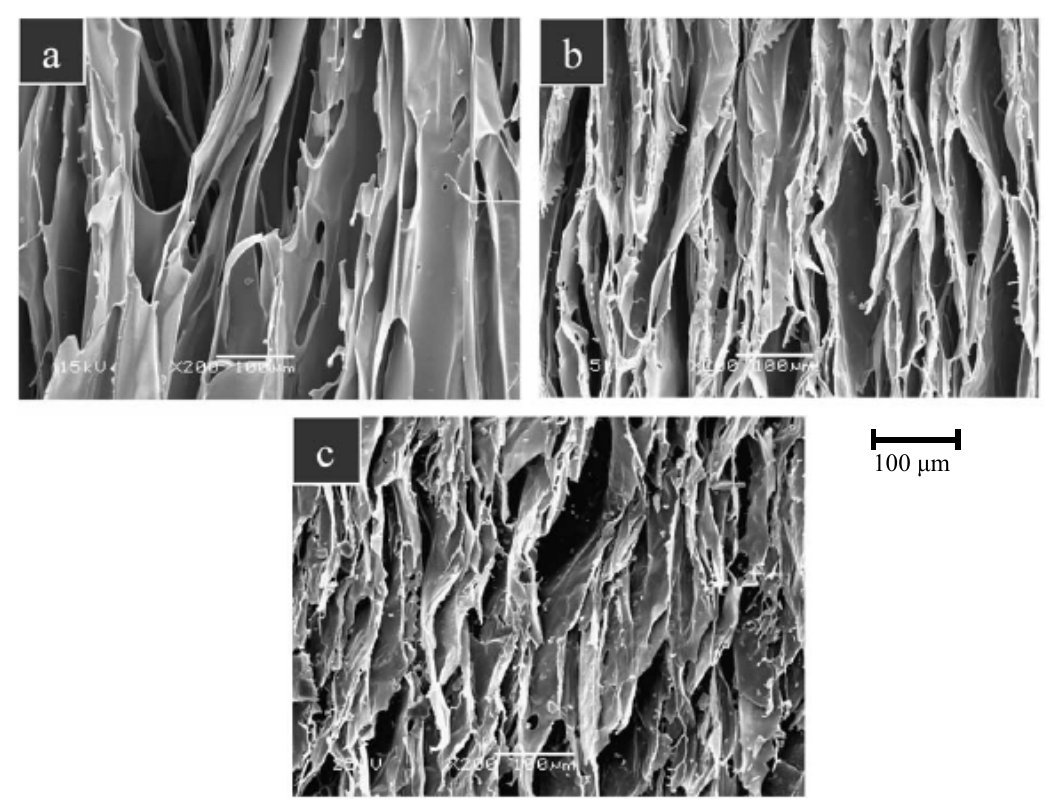
Figure 14. SEM images of a PDLLA/Bioglass ® scaffold fabricated by TIPS showing the typical homogeneous, tubular regions of (a) pure PDLLA foam, (b) PDLLA / 4.8 wt % Bioglass ® foam, (c) PDLLA / 28.6 wt % Bioglass ® foam [160]. Figure reprinted with permission of